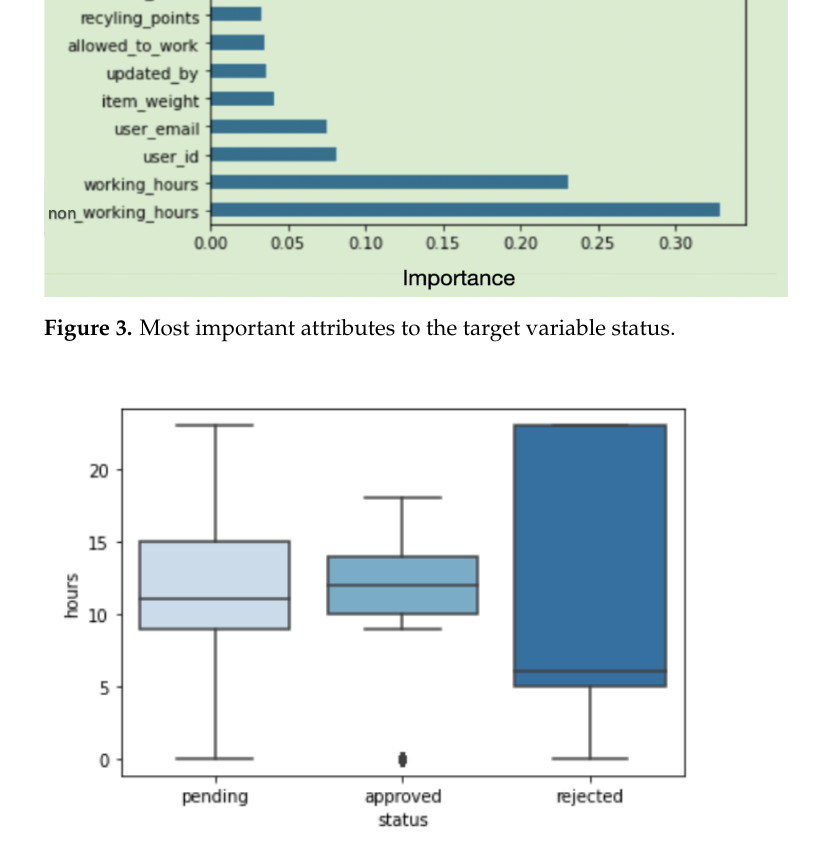
Figure 4. Relationship between target variable and transaction time.